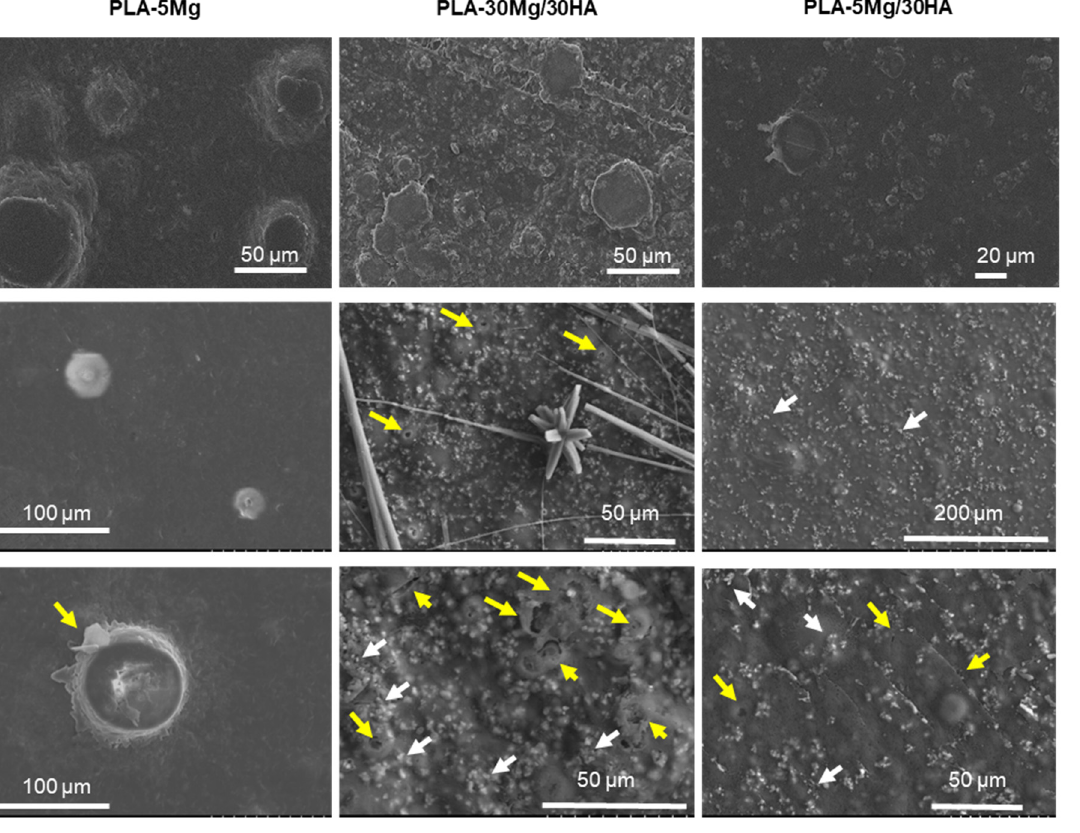
Figure 4. SEM micrographs of the surface of the membranes after immersion in PBS. Yellow arrows indicate PLA surface degradation and white arrows indicate precipitated Ca nodules. Table 2. Membrane surface properties : surface average roughness (S a ), average height to the peaks (R h ), Kurtosis parameter (S ku ), average contact angle ( ϑ ).